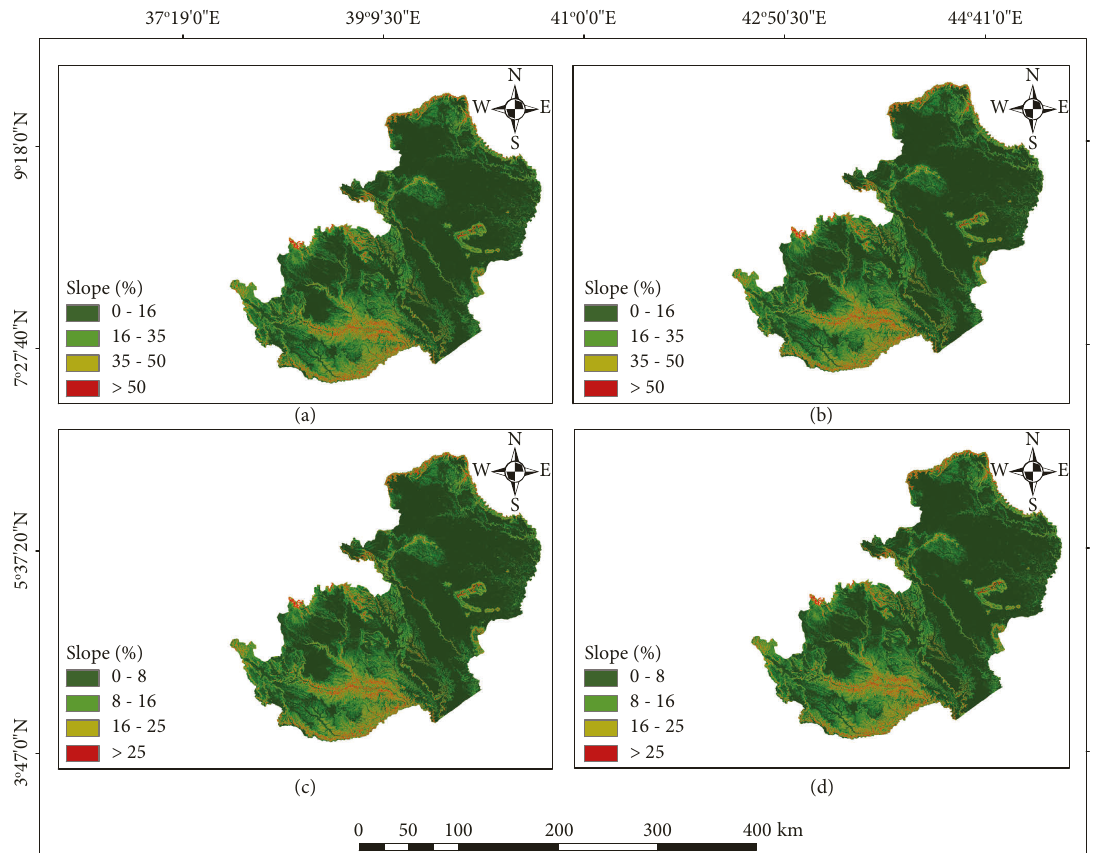
Figure 4: Slope factor map for livestock production: (a) goat, (b) sheep, (c) camel, and (d)